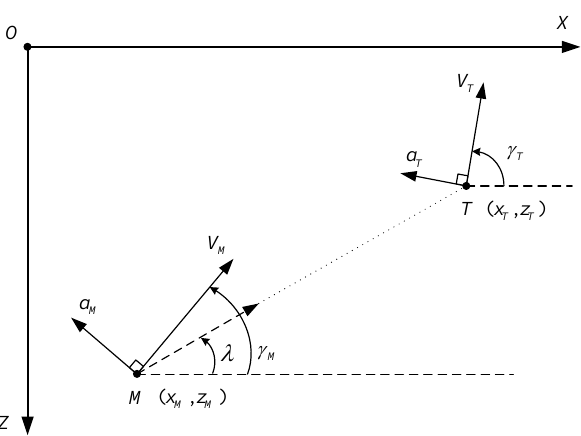
Figure 1. Two-dimensional engagement geometry for a moving